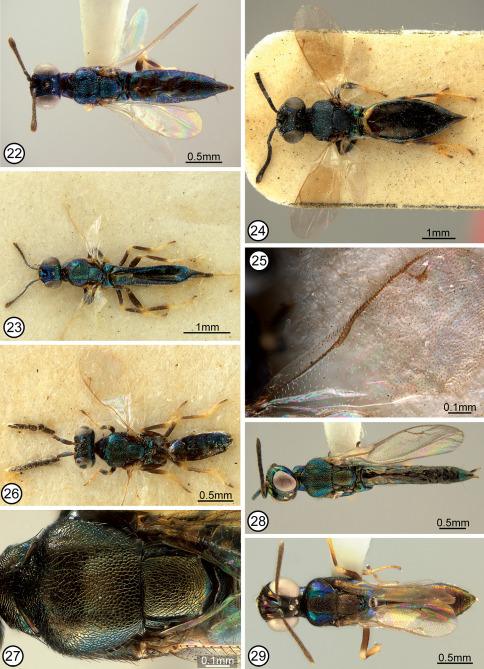
22−24 dorsal ♀ habitus: 22 Calosota metallica (29) 23 Calosota grylli (lectotype) 24 Calosota lixobia (paralectotype 6581). 25−26 Calosota modesta ♂ (holotype): 25 right fore wing 26 dorsal habitus 27 Calosota vernalis ♀, dorsal mesosoma (43) 28−29 dorsal habitus: 28 Calosota acron ♀ (13) 29 Calosota speculifrons ♂ (allotype). Numbers in parentheses = CNC Photo 2009-no.